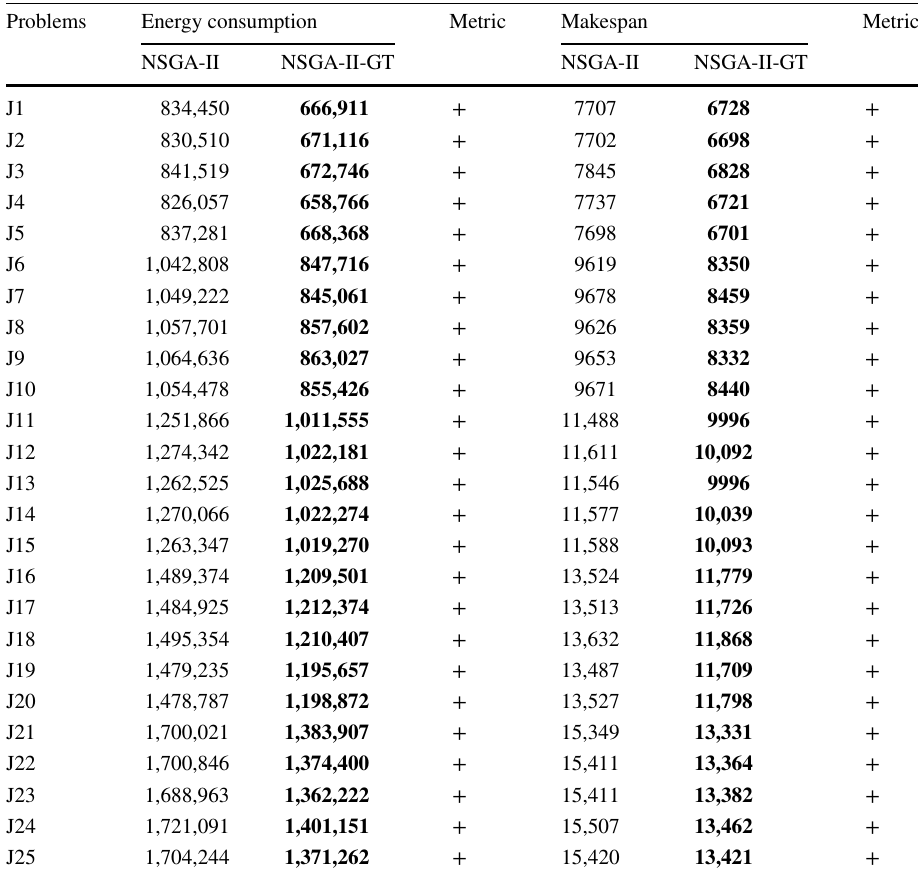
Table 2 The average energy consumption and the average makespan obtained by NSGA-II and